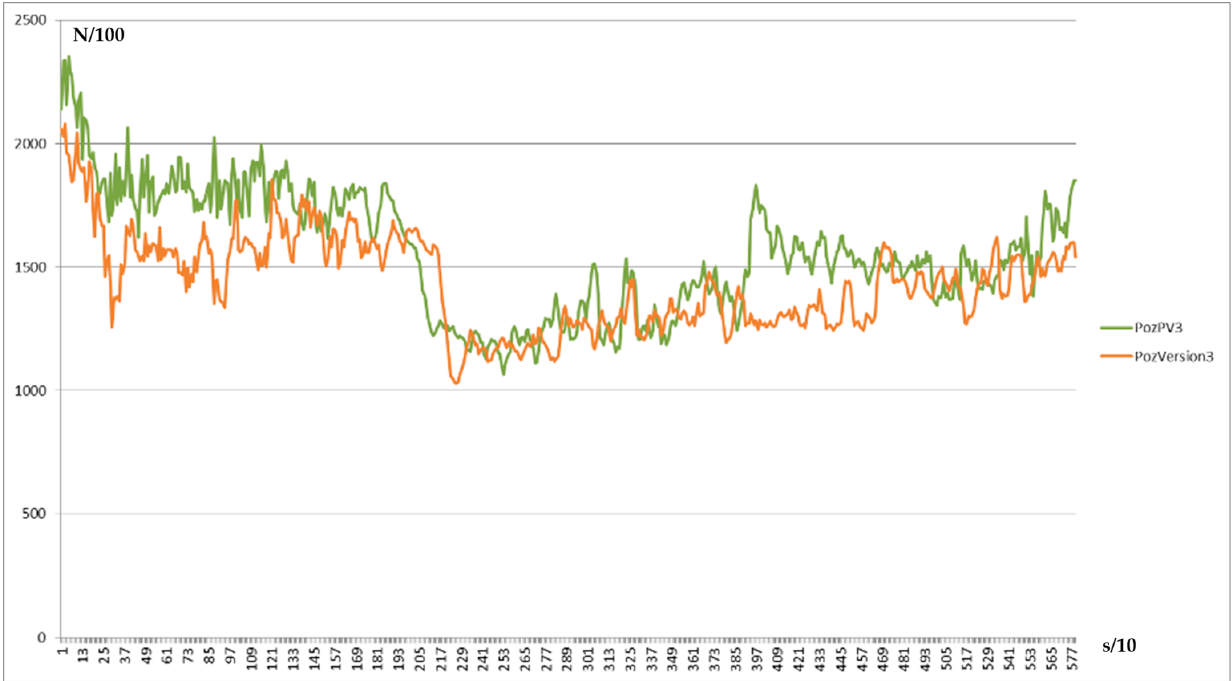
Figure 15. Proportional control